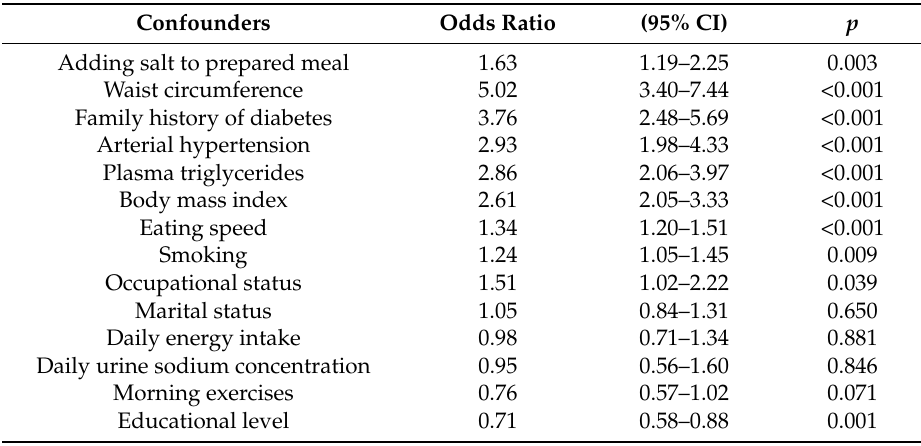
Table 2. Unadjusted odds ratios and 95% confidence interval for type 2 diabetes mellitus.